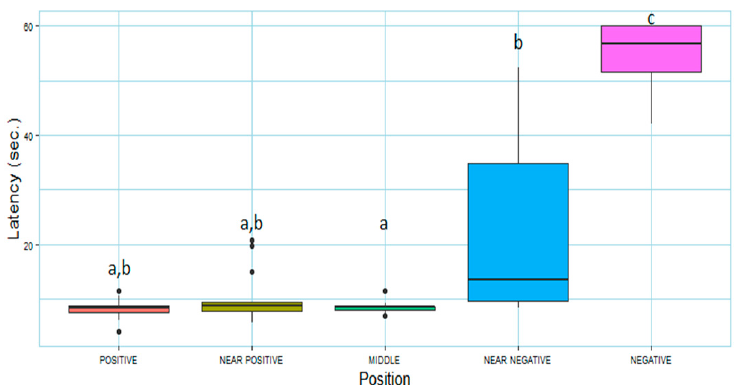
Figure 2. Latency in seconds (sec.) to reach the bucket in the five locations. Results refer to the two days of the test. The bar within the box represents the median, the borders of the box are upper and lower quartiles, the bottom and top whiskers signify the lowest and highest cases within 1.5 times the interquartile range (IQR), and outliers are shown through black full circles. a, b, and c indicate significant results ( p < 0.05).